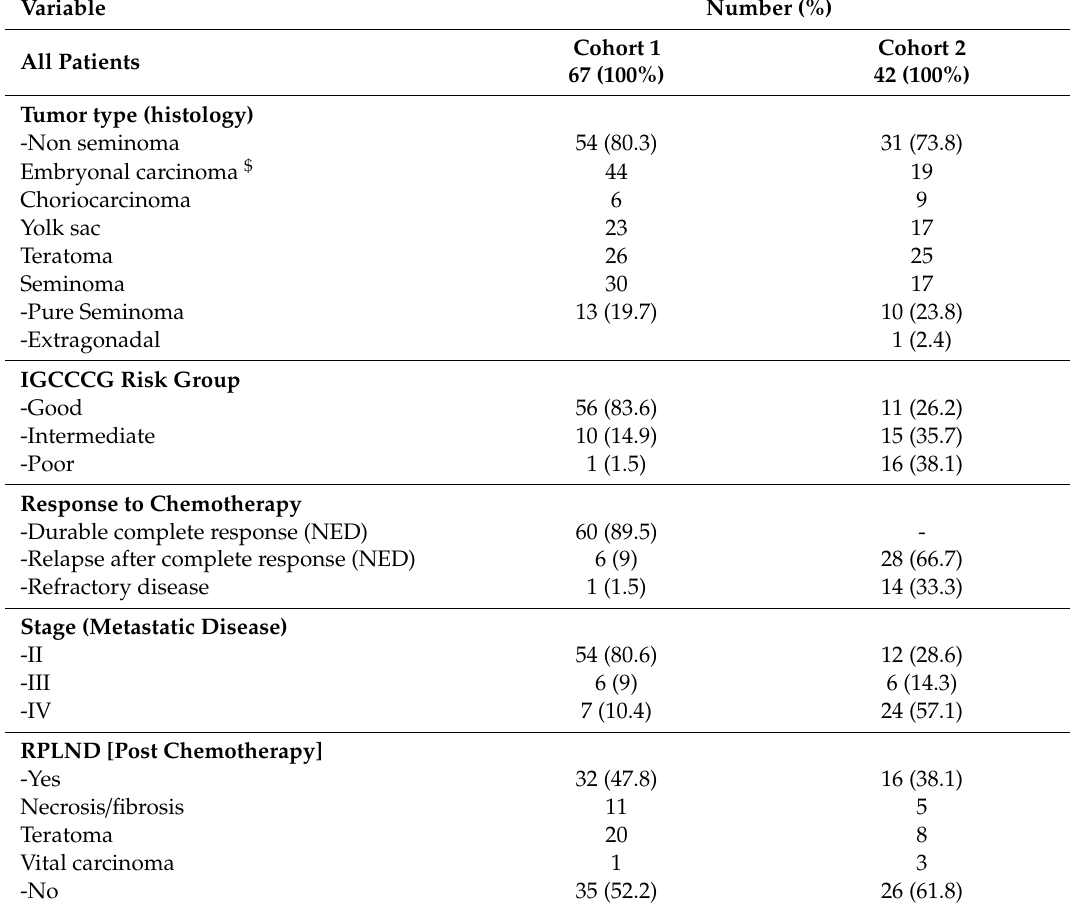
Table 1. Clinical characteristics of cohorts 1 and